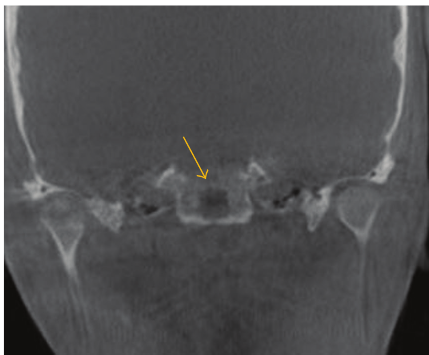
Figure 10: Coronal view demonstrates lytic lesion in the